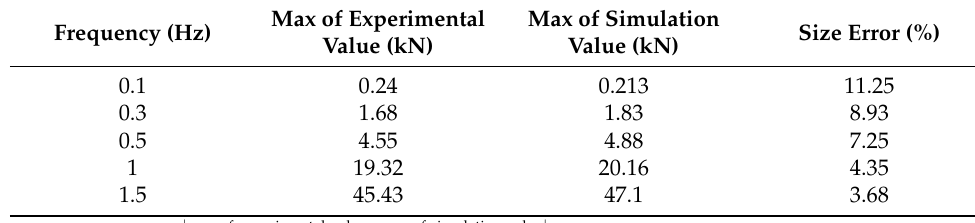
Figure 14. The force value of 60 mm at different frequencies. Table 4. Table of theoretical and experimental force values.